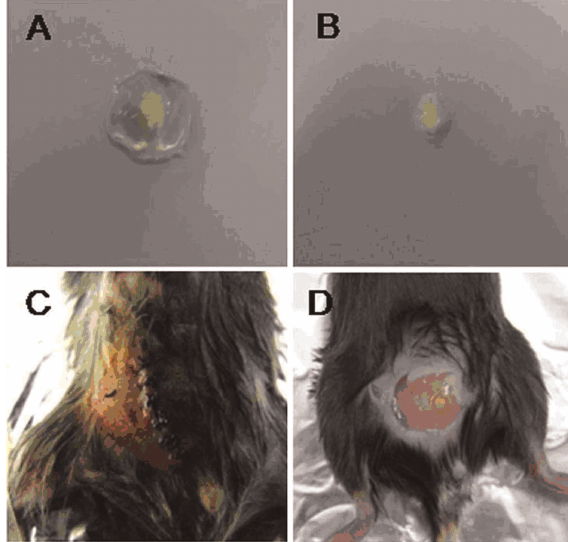
natural cell block. The quasi-natural cell block cultured for 7 days ( A ) was harvested by removing its surrounding Matrigel TM -cast for transplantation ( B ). The quasi-natural cell block was implanted into subcutaneous tissue of a female mouse ( C ) and allowed to adapt in vivo for 4 weeks, showing successful connection with the surrounding tissue of the recipient ( D